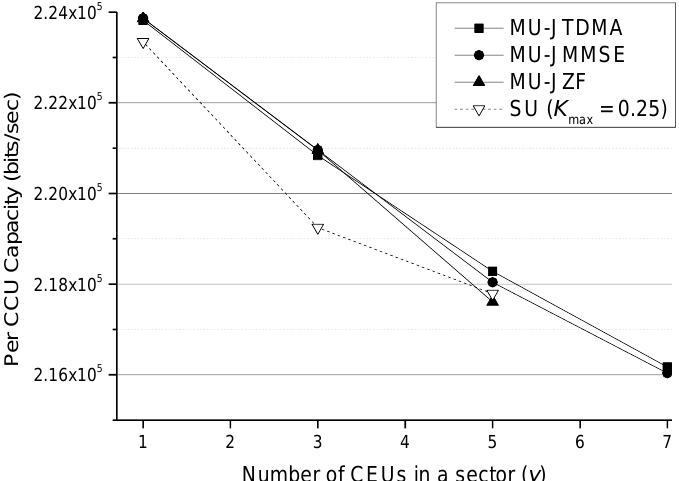
Figure 6. Per-CCU capacity comparison between the MU and SU-network MIMO.